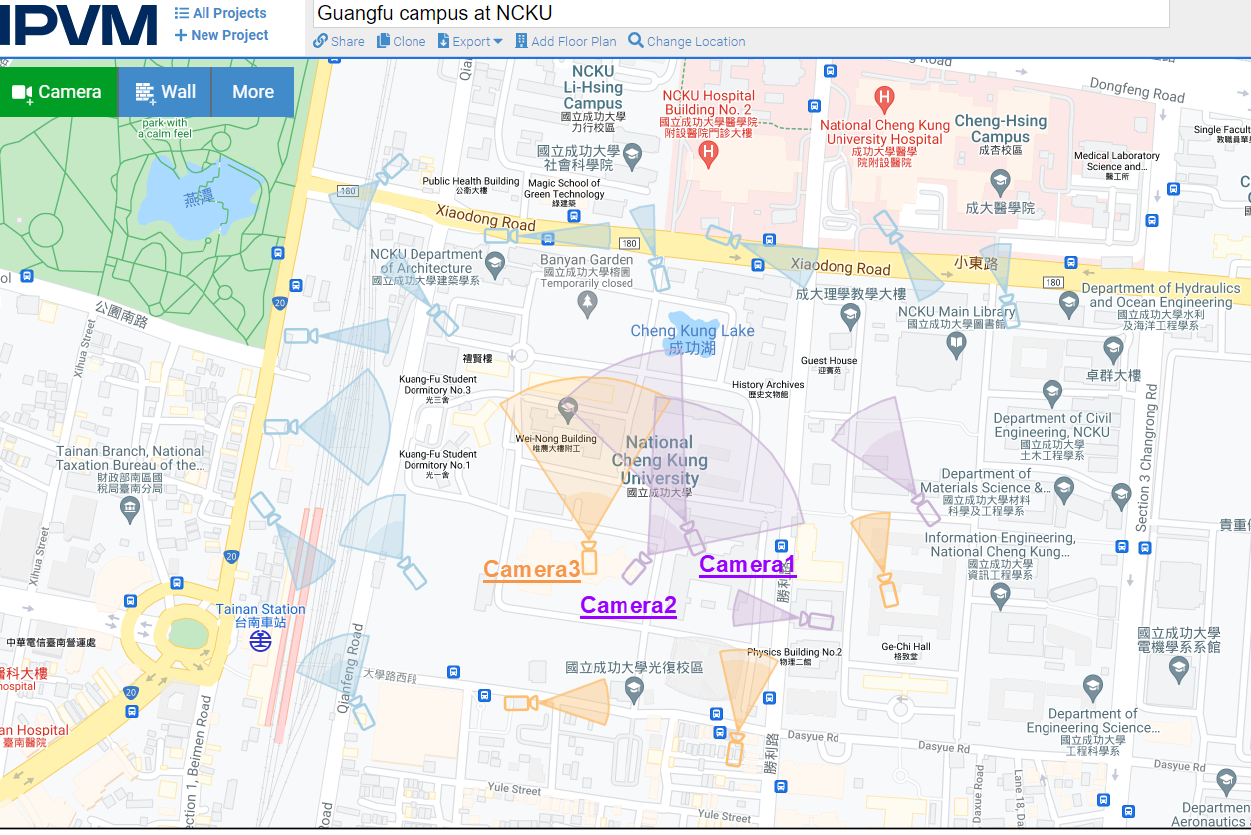
Figure 10. The test data in this study (The Chinese on figure represents the Landmark name or road name. Source: https://calculator.ipvm.com/ accessed on 21 July 2021). Table 4. Camera 1 CCTV’s metadata designed.